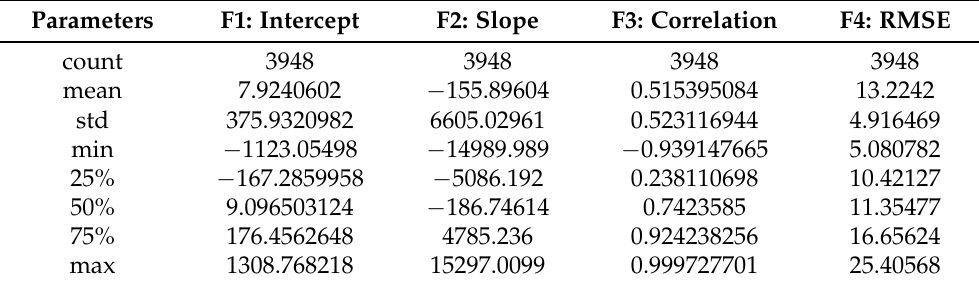
Table 4. Statistical information of ZCP dataset with THD level 50% and noise level from 10% to 40%.